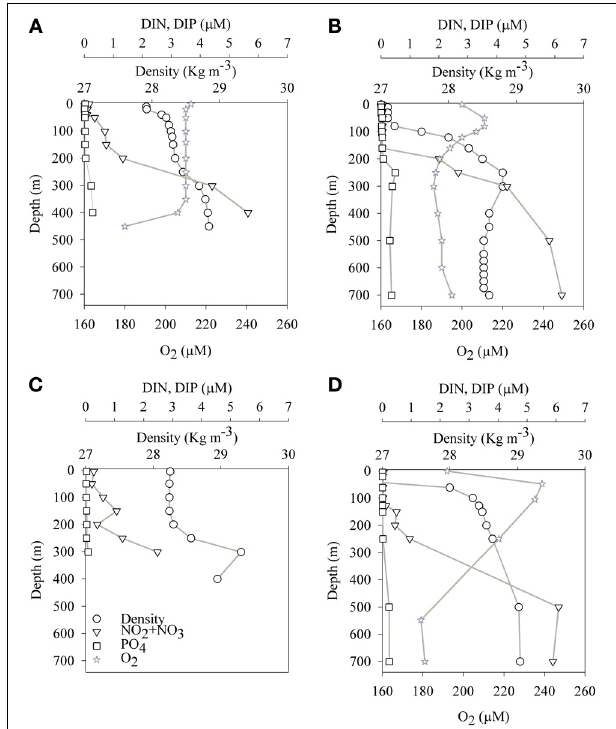
FIGURE 1 | Spatial (depth) and temporal changes of physical and chemical parameters at the sampling stations in the Gulf of Aqaba (A,B) and Levantine basin (C,D) during the mixed (A,C) and stratified (B,D)